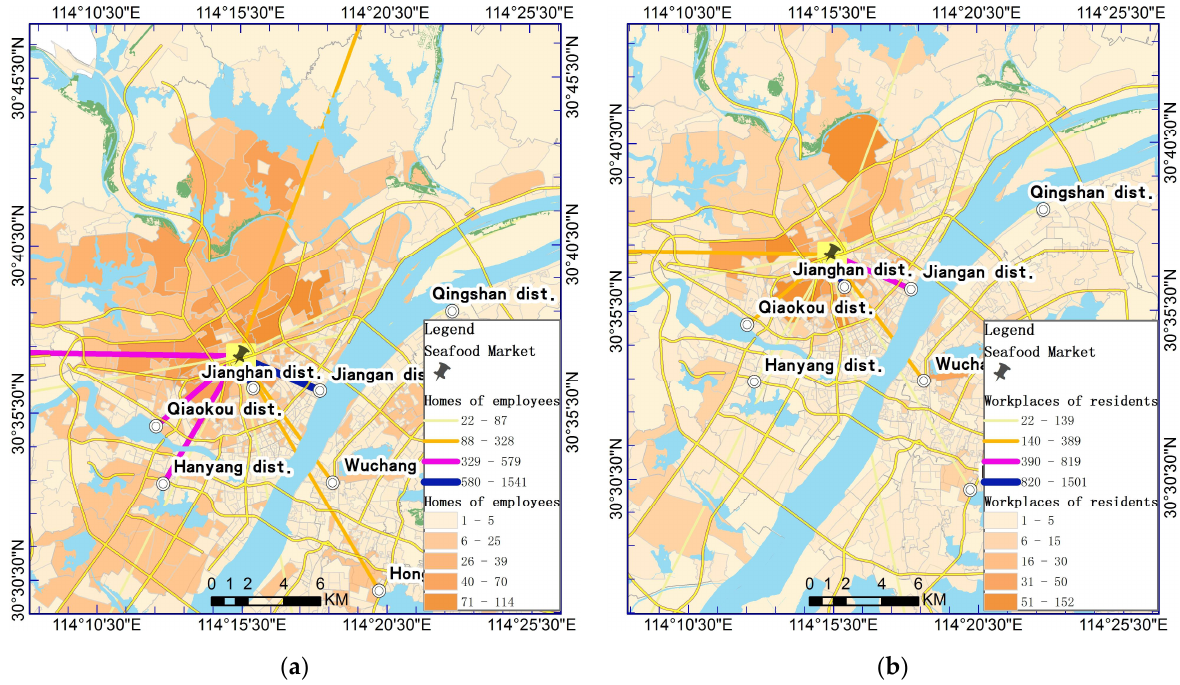
Figure 8. Distribution of the commuters nearby the market (( a ) distribution of the nearby residents’ workplaces; ( b ) distribution of the nearby employees’ homes). Table 3. Origins and destinations of the commuters nearby the market.